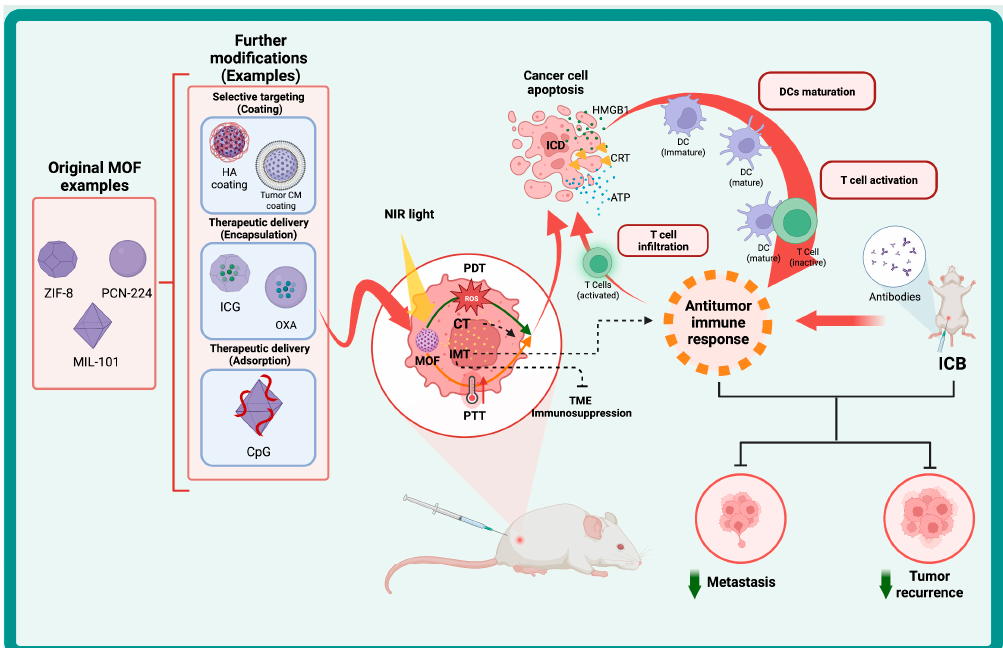
Figure 1. Metal-organic frameworks (MOFs) types, modifications, and synergistic cancer photo- immunotherapy mechanisms. Commonly used MOFs for biomedical applications, such as ZIF-8, PCN-224, and MIL-101, can be modified in a rational design for selective targeting and function as nanocarriers for therapeutic drug delivery (e.g., immune adjuvants (CpG), chemotherapeutic agents (OXA) and photothermal agents (ICG)) into the TME. The incidence of NIR light in tumor cells containing the MOF can trigger either PDT or PTT depending on the intrinsic properties of the MOF or the photosensitizer loaded. The intracellular environment of the tumor, as well as the NIR light, can trigger the release of chemotherapeutic and immunotherapeutic agents that can synergize through ROS production or immunotherapeutic effects. PTT and PDT-induced ICD triggers the exposure of CRT, HMGB1 release, and ATP secretion, subsequently inducing DCs maturation. DCs present tumor antigens to naïve T cells, activating them and triggering an antitumor immune response, consequently increasing the infiltration of T cells at the tumor site. Synergetic therapy with ICB promotes an enhanced systemic antitumor immune response, conferring protection against metastasis and tumor recurrence. Abbreviations: HA, hyaluronic acid; CM, cell membrane; ICG, indocyanine green; OXA, oxaliplatin; CpG, cytosine-phosphate-guanine; NIR, near-infrared region; MOF, Metal-organic framework; PDT, photodynamic therapy; PTT, photothermal therapy; IMT, immunotherapy; CT, chemotherapy; TME, tumor microenvironment; ICD, immunogenic cell death; DC, dendritic cell; ICB, immune checkpoint blockade. Created with BioRender.com.